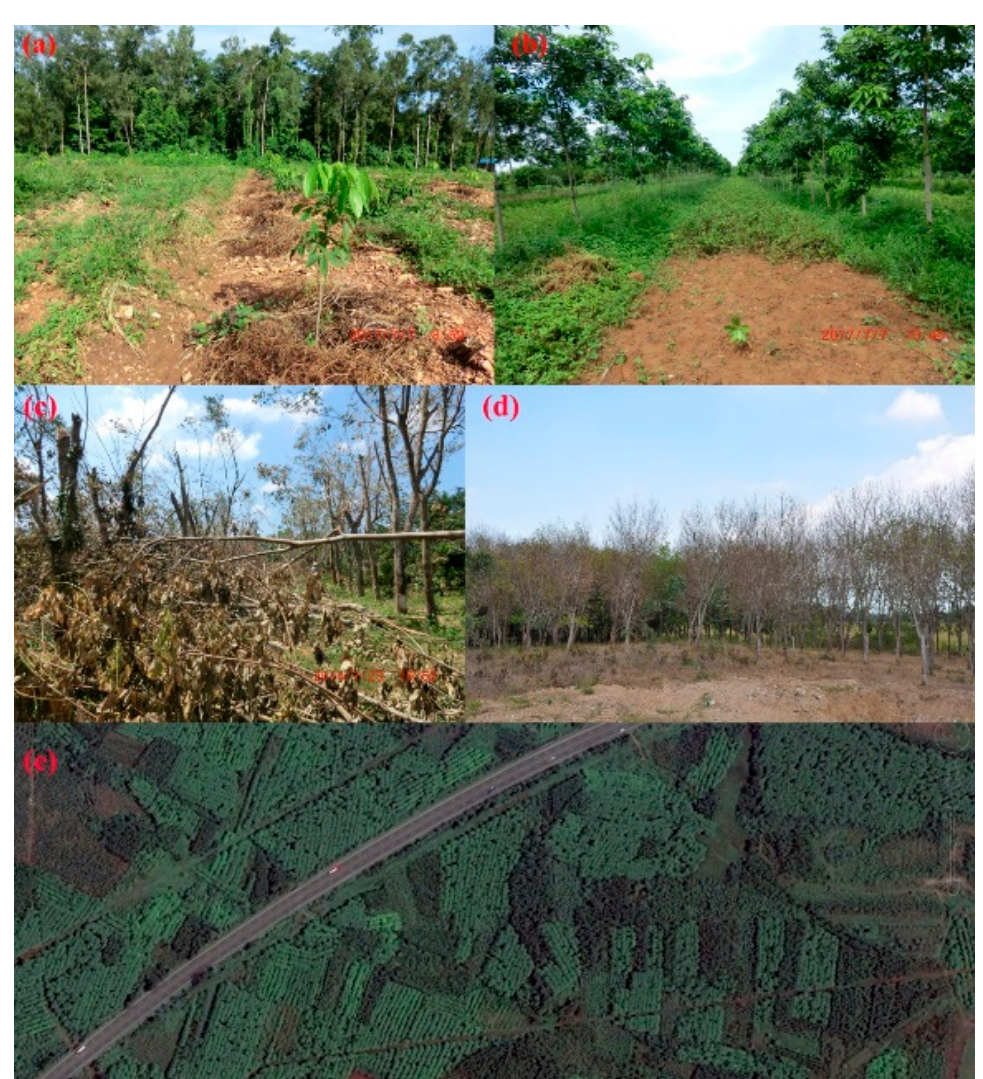
Figure 12. Uncertainties in mapping the establishment year of rubber plantations: ( a ) seedling rubber plantation established in 2016, where most vegetation was cleared for green manuring; ( b ) rubber plantation established in 2013 and intercropped with peanut, where the bare soil background appeared when harvesting peanuts; ( c ) plantation destroyed by super typhoon Rammasun in Wenchang City in 2014; ( d ) drought-afflicted plantation taken in Guangba State Farm, Dongfang County in 2010; and ( d ) typical tropical fragmented landscape (around 19.86377°N, 109.74850°E) from Google Earth VHR imagery acquired on 15 April 2016 in Lingao County. Rubber plantations are shown in sea green. Photos of ( a , b ) were taken at the experimental farm managed by the Chinese Academy of Tropical Agricultural Sciences (CATAS) on 7 July 2017.